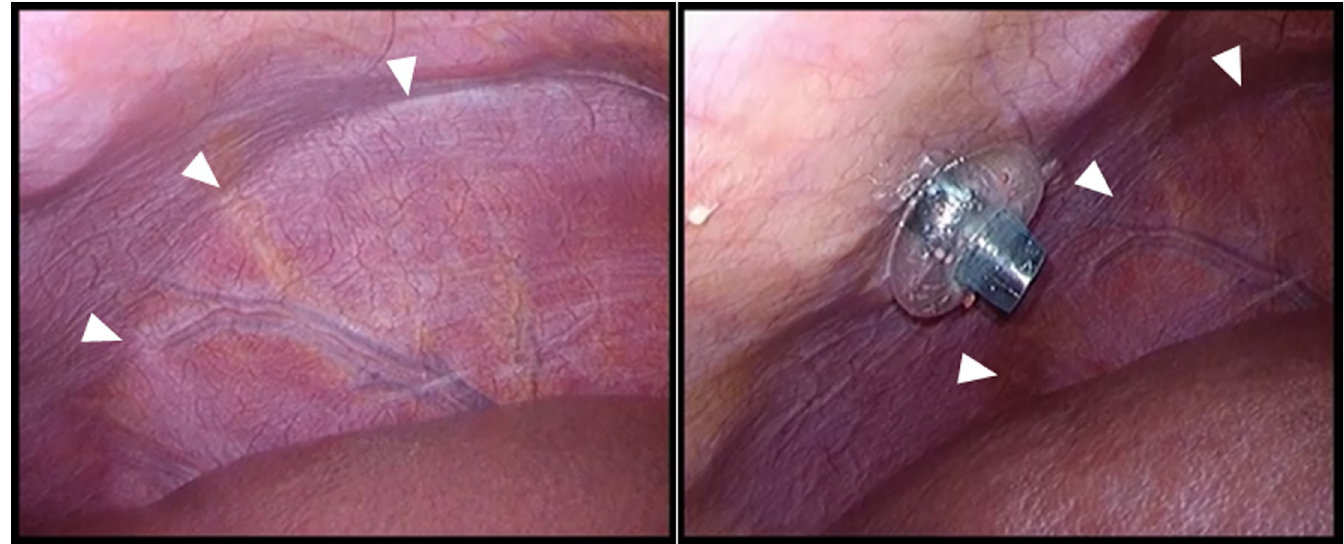
Fig 1. Lung edge can be confirmed by ventilation. Arrowheads indicate the lung